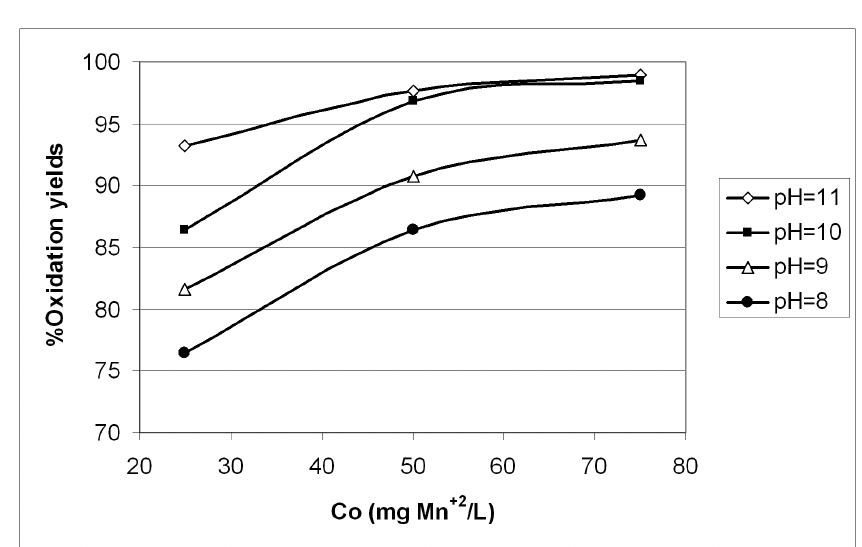
Fig. 6 Oxidation yields as a function of pH and concentration (20 ◦ C, solution with glass beads and 0.5 g clinoptilolite).